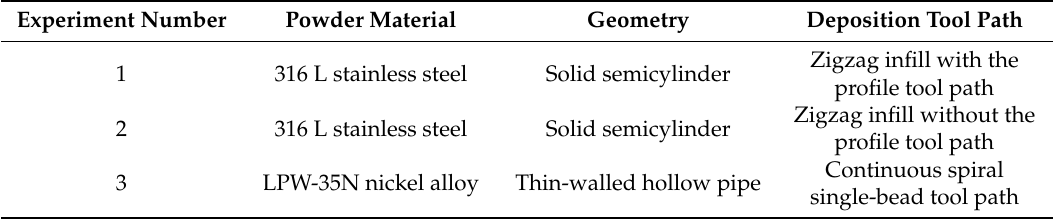
Table 1. Materials, geometries, and deposition tool paths in di ff erent experiments.